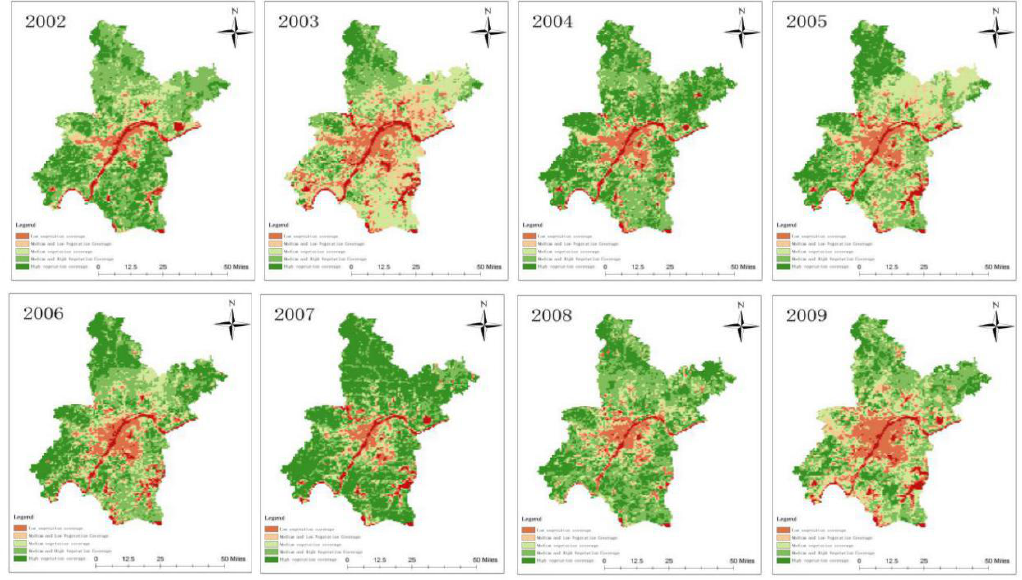
Fig.4 Classification of vegetation coverage in